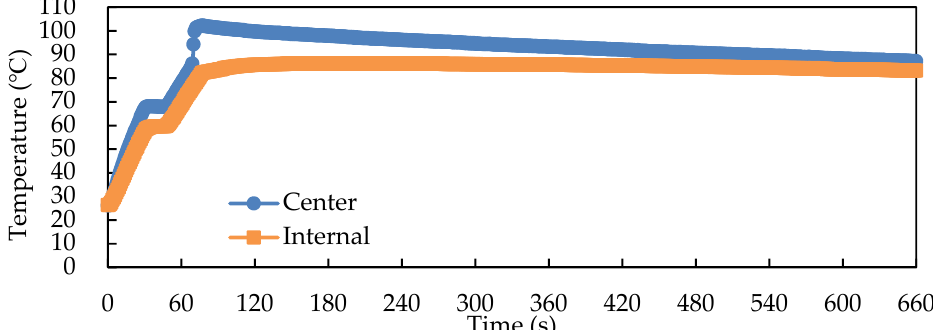
Figure 4. RF pasteurization with an electrode gap of 15 cm for solid-state fermented W. cocos products after 7 d of cultivation.